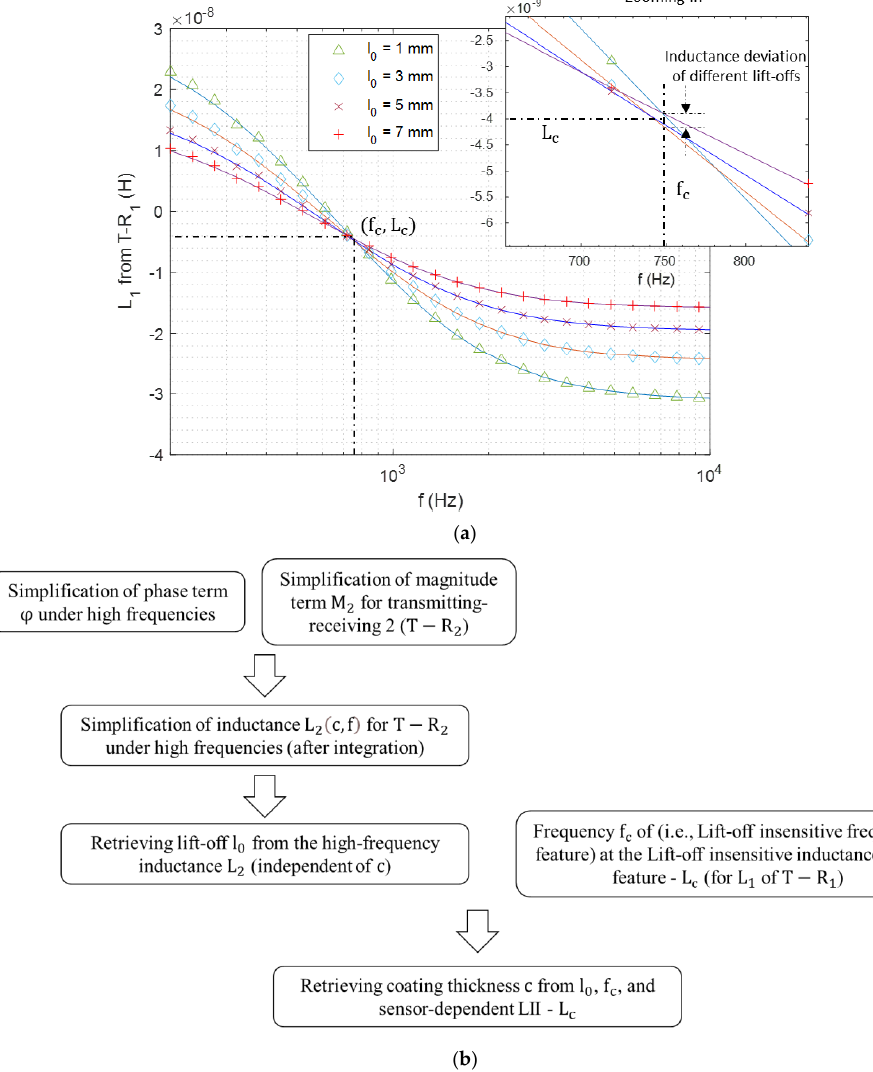
Figure 3. ( a ) Swept-frequency inductance curves of different lift-off distances (solid lines — analytical results via Equation (1), markers — experimental results) for T − R 1 above the substrate (DP 1000) with aluminium coating of 0.3 mm (Table 1). ( b ) Algorithmic flowchart.